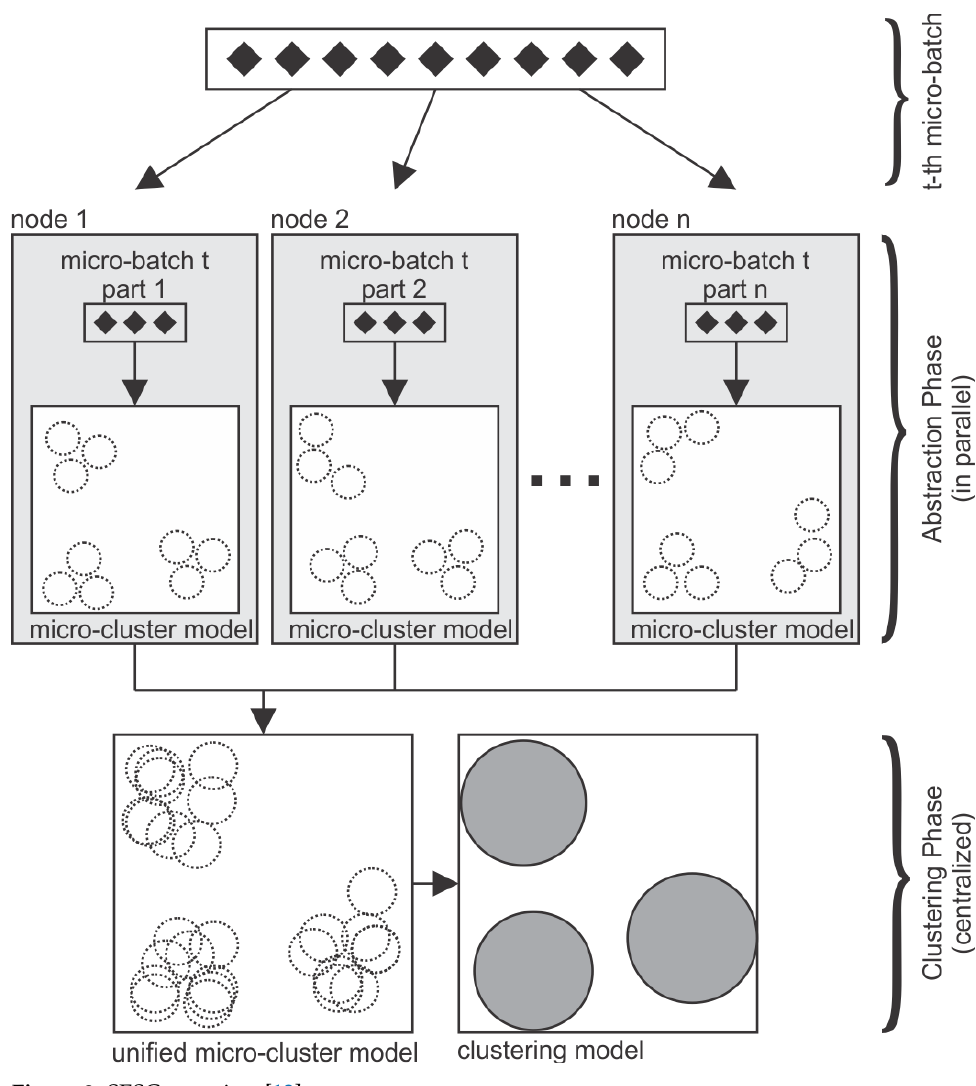
Figure 3. SESC overview